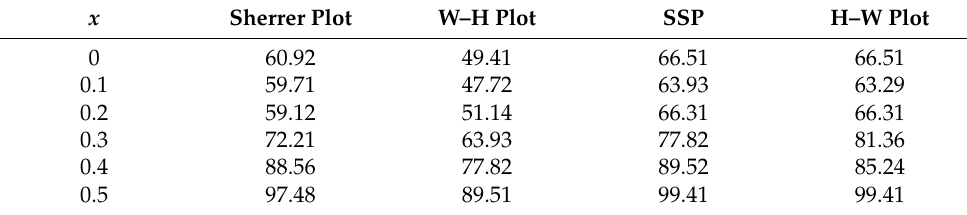
Table 2. The average crystallite size values for all prepared samples by different methods. x Sherrer Plot W–H Plot SSP H–W